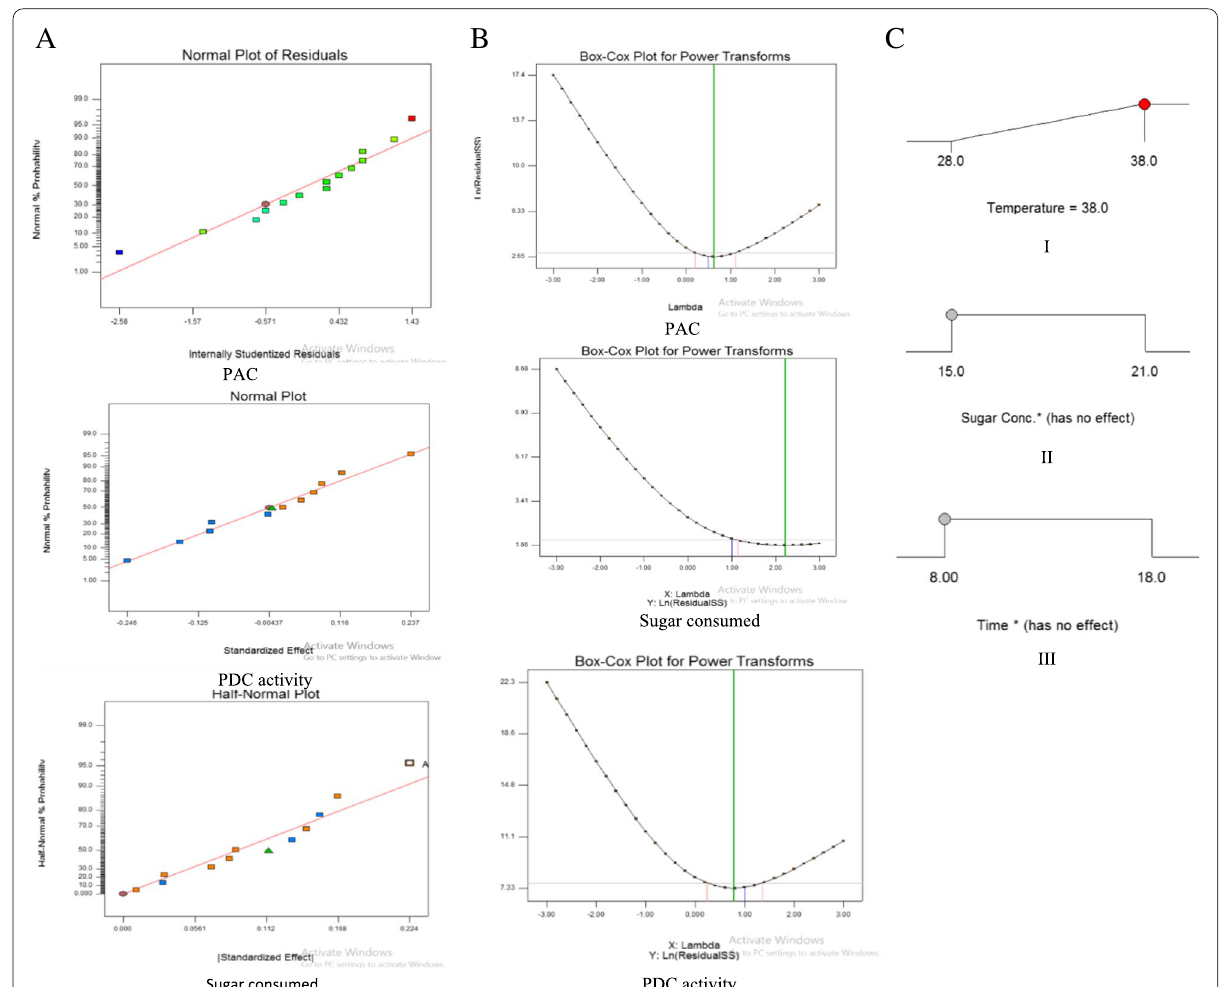
Fig. 3 A Linear plot for PAC, PDC activity, and sugar consumed. B Box- C ox graphs for PAC (g/ l ), sugar consumed (% age, v/v) , and PDC activity (U/ ml) . C Ramps depicting the impact of factors on pyruvate decarboxylase activity. Sugar conc. and incubation time have no effect. Temperature